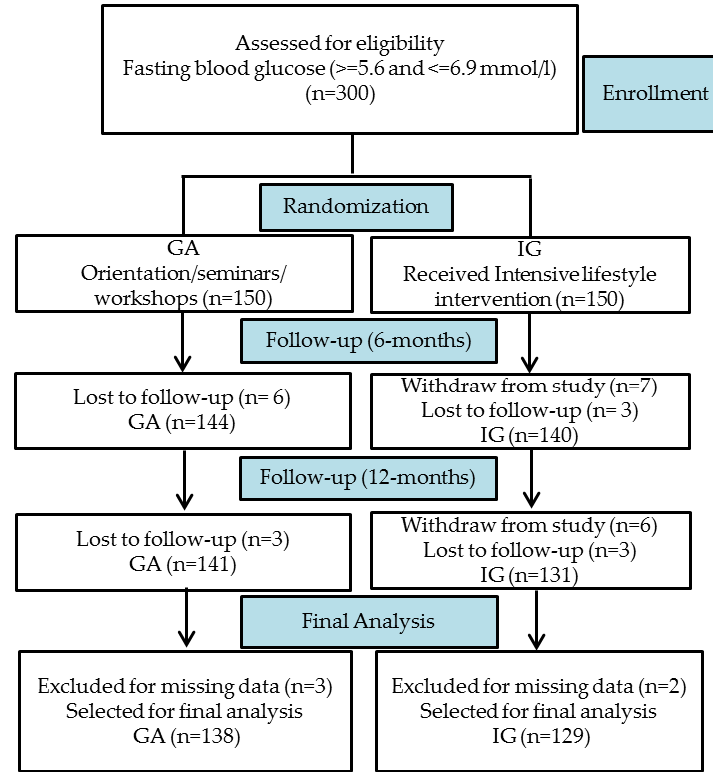
Figure 1. Flow chart of study participants.